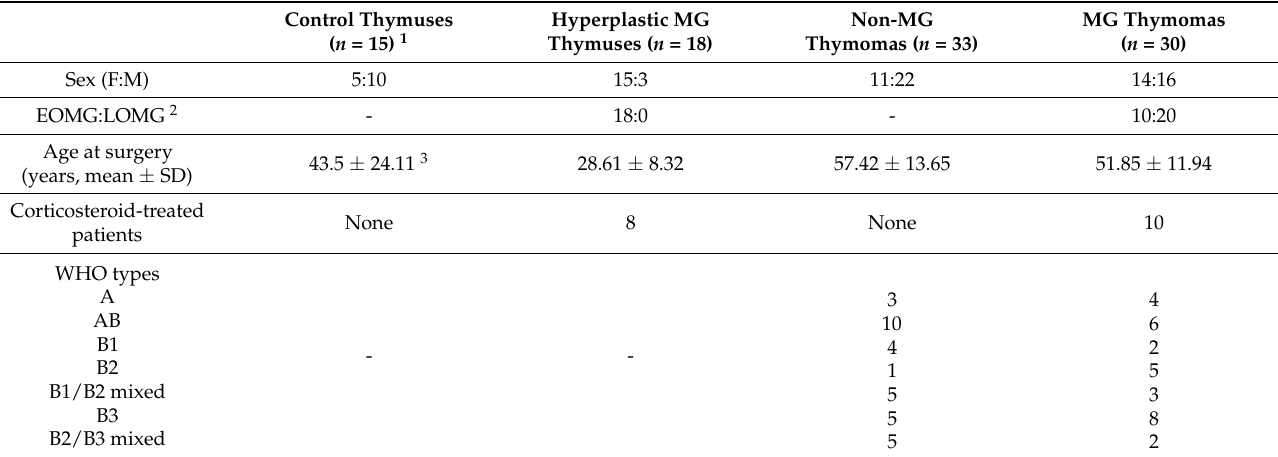
Table 1. Main features of MG patients and controls included in the